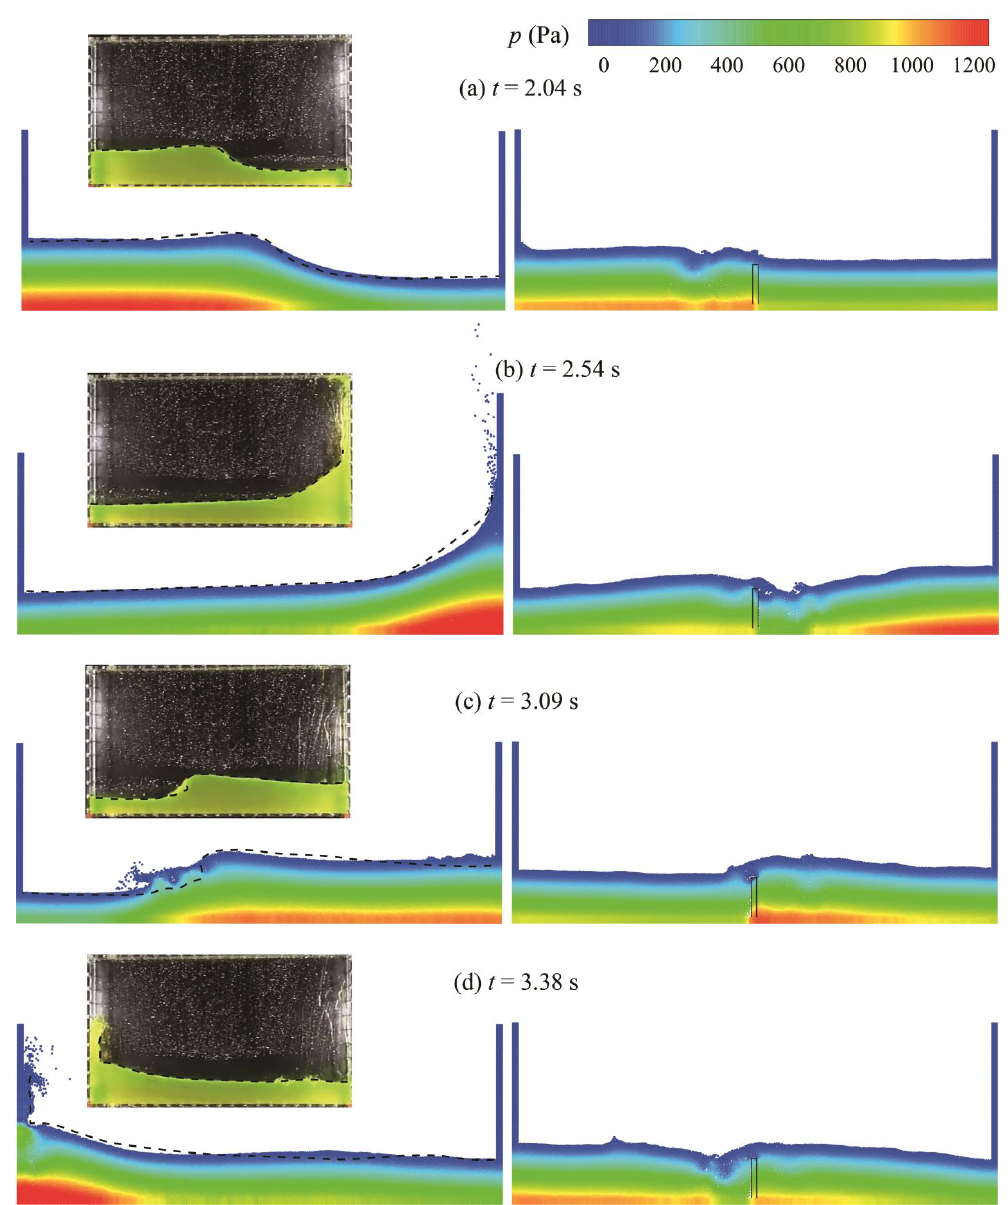
Figure 3. Snapshots of sloshing flow with pressure field under the excitation period T = 1.91 s. ( a ) t = 2.04 s; ( b ) t = 2.54 s; ( c ) t = 3.09 s; ( d ) t = 3.38 s. (Left: without a baffle; Right: with a vertical baffle H B / h 0 = 0.8; The dash lines are the free surfaces extracted from the experimental images. The image data are available at http://canal.etsin.upm.es/ftp/SPHERIC_BENCHMARKS/case_2/index.html, accessed on 25 September 2021. As for the experiment information, please refer to reference [22]).